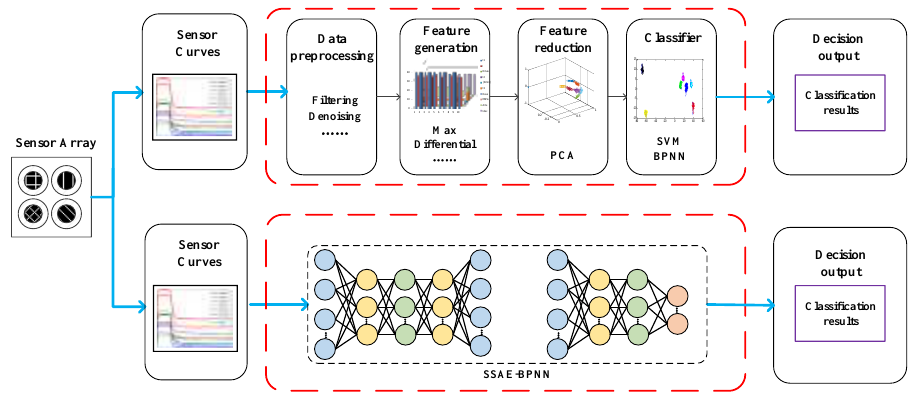
Figure 4. SSAE-BPNN vs. Traditional methods.